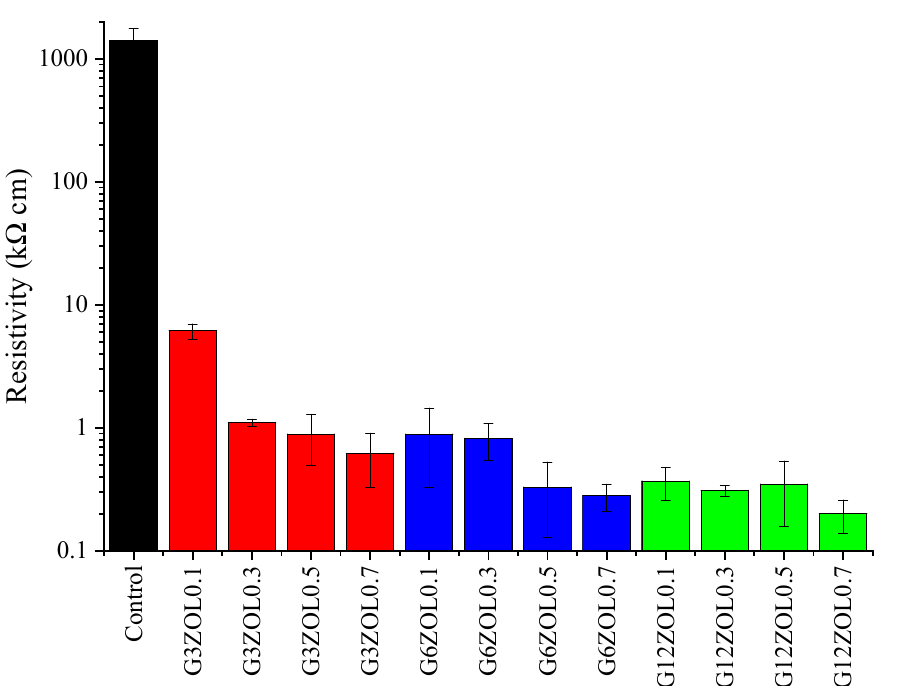
Figure 5. Resistivity variation of the geopolymer mixes. Both the reflection and transmission EMI-shielding properties of each mix were measured in accordance with ASTM D4935-18 standard [32]. Figure 6 shows the EMI-shielding properties of the specimens containing 3 mm CFs along with the control mix. Transmission-shielding properties show a gradual increase with the increase in the CF content. While the control mix shows an extremely low level of shielding, the addition of even 0.1% of CFs has a significant improvement on the shielding. However, when the CF content is increased further, the SE seems to reach an optimum level, as the increase in the SE does not show a significant variation. Additionally, mixes with higher CF percentages show near-identical shielding properties in the lower frequency range. However, with the increase in the frequency, the SE of the mixes also deviates in specimens with higher CF content having better SE.